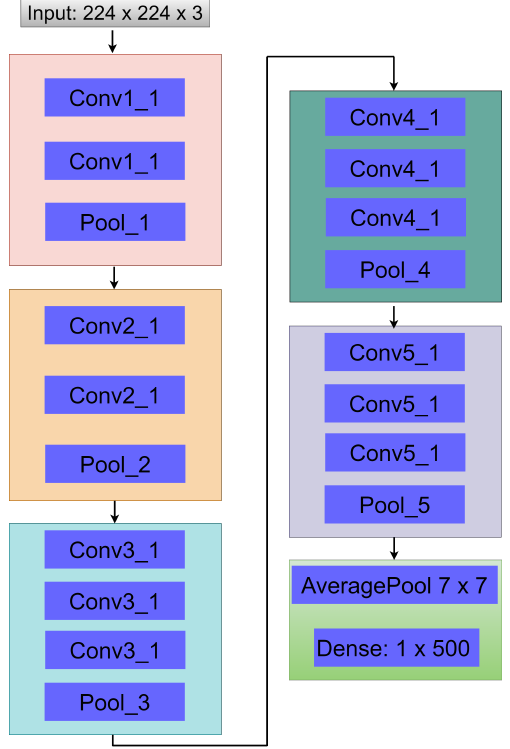
Figure 6. Structure of the fine-tuned VGG-16 network used to extract DR and non-DR related features from CECED fundus images.